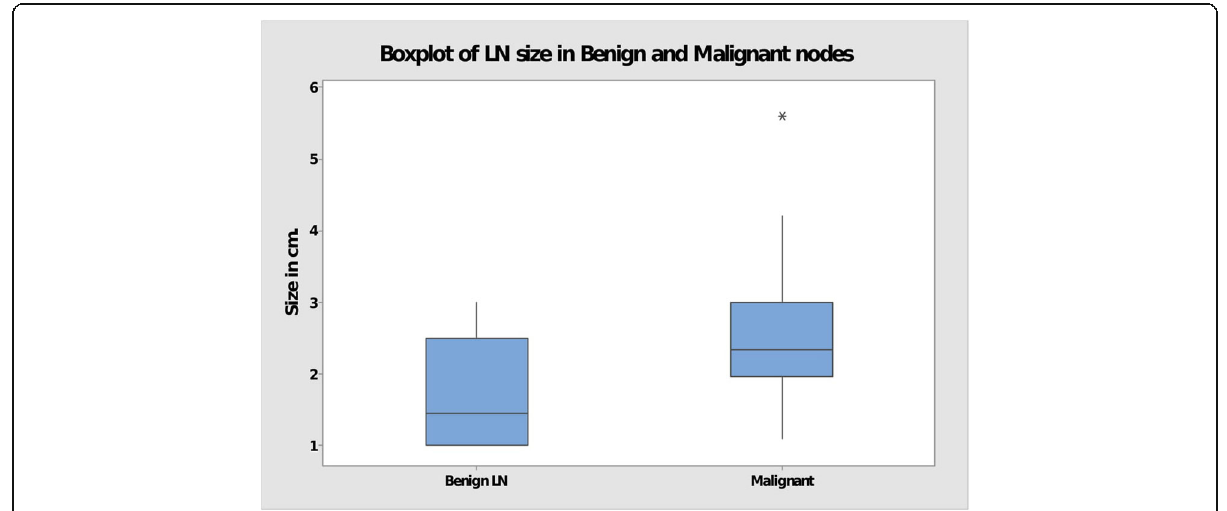
Fig. 2 Boxplot of LN size in benign versus malignant lymph nodes